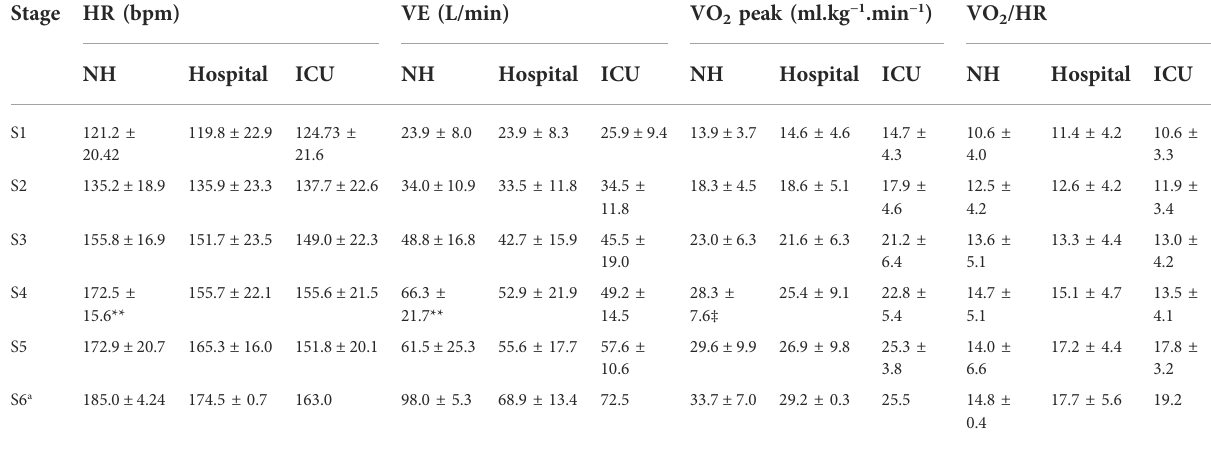
TABLE 2 Physiological variables in each stage of the Bruce test for COVID-19